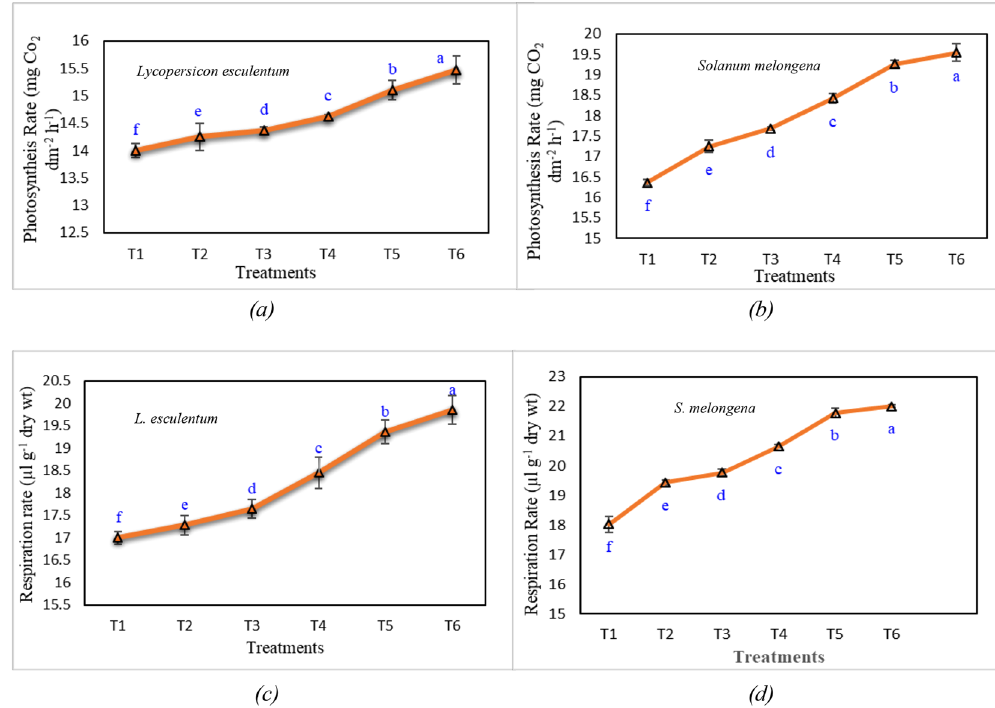
Figure 7. Photosynthesis and Respiration rate during harvesting of Lycopersicon esculentum and Solanum melongena dusted at different rates of vermicomposted fly ash. Illustration: Values are in Mean ± SD; (n = 3). Different letters at each data point of the line graph depict significant differences in the photosynthetic and respiration rates respectively at p < 0 . 05 (One-Way ANOVA). The normality and homogeneity of variances were verified, respectively, by Shapiro-Wilk and Levene values at p > 0 . 05